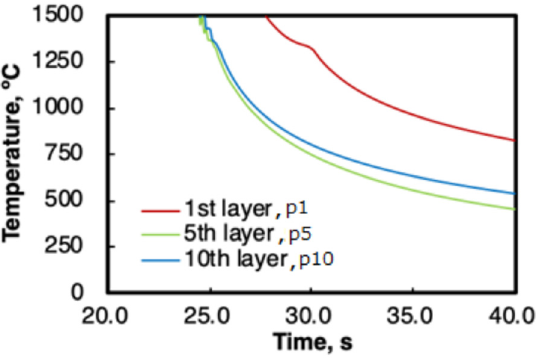
Figure 3. Temporal temperature variations at the first, fifth, and tenth layer.